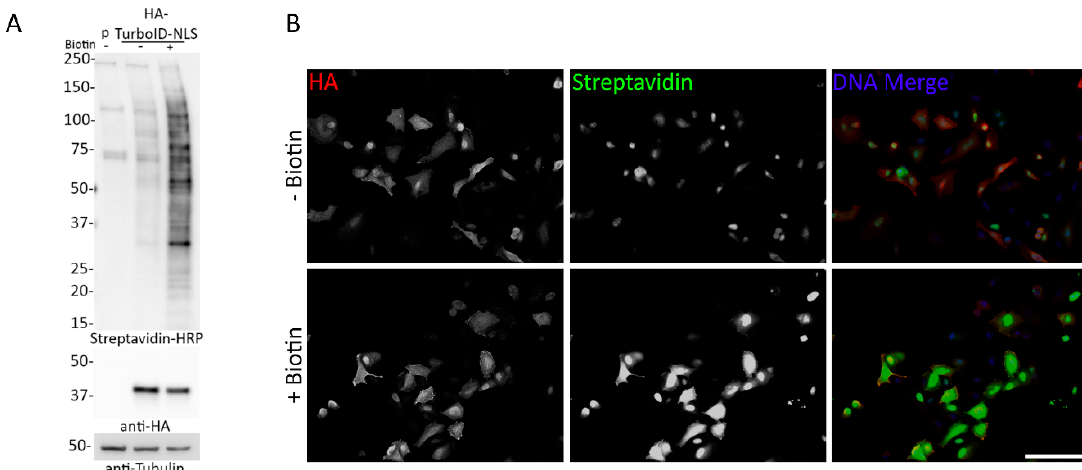
Figure 8. Transient transfection of TurboID in A549 cells does not improve inducibility of biotinylation. ( A ) A549 cells transiently transfected with HA-TurboID-NLS were analyzed for expression (anti-HA) and biotinylation (Streptavidin-HRP) in the presence and absence of biotin (10 min) via WB. 24 h after transient transfection, cells were exposed to biotin for 10 min. Anti-tubulin was used as a protein loading control. ( B ) Epifluorescence images of A549 cells transiently transfected with HA-TurboID-NLS. Anti-HA was used to detect protein localization and fluorescently conjugated streptavidin was used to visualize biotinylation. Hoechst dye was used to detect the DNA in the nucleus (blue in merge). Scale bar 10 μ m.